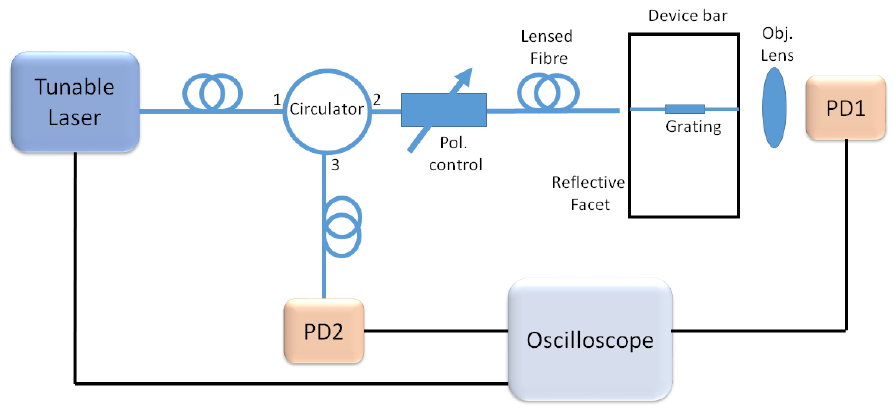
Figure 12. Transmission and group delay measurement setup. (Pol., polarisation; PD,